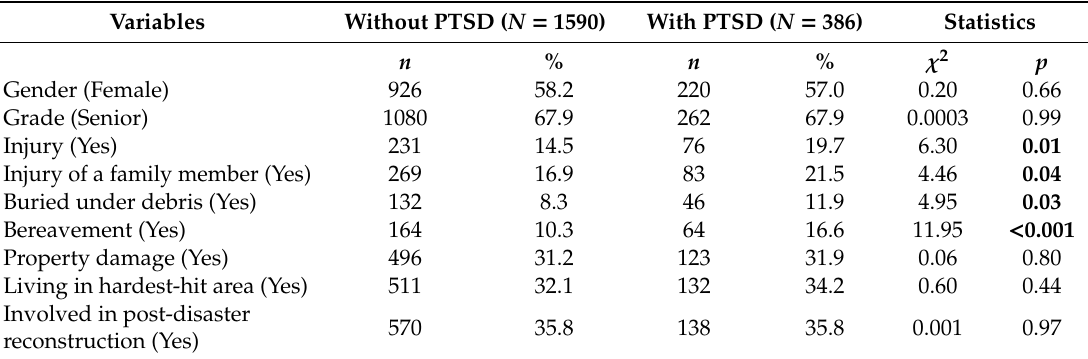
Table 4. Univariate analyses of PTSD among adolescent survivors.